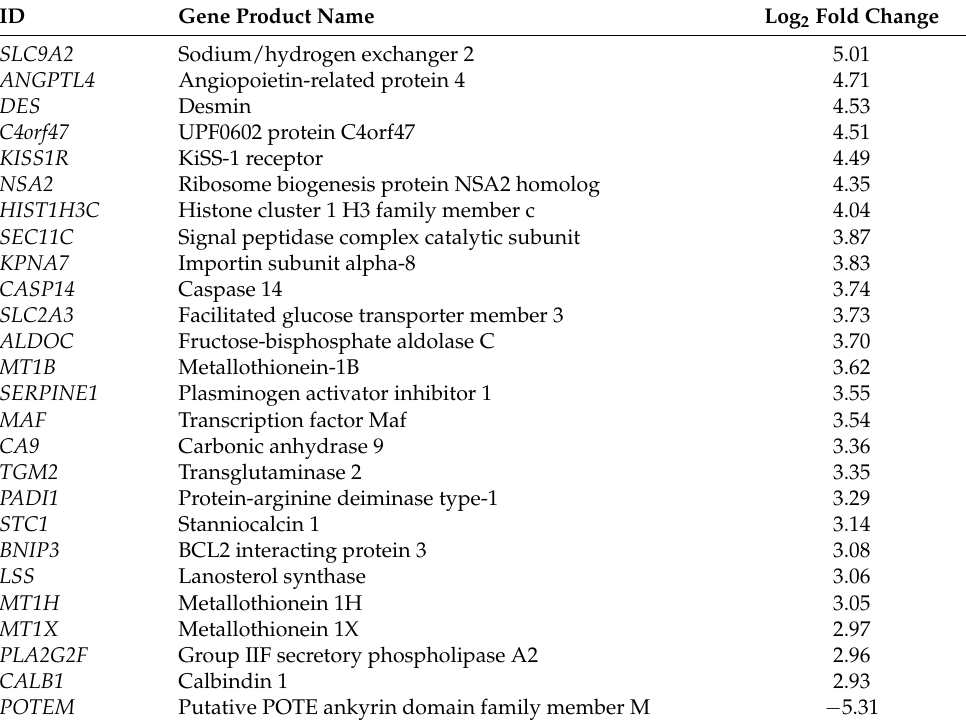
Table 1. The major up- and down-regulated genes in HaCat cells after 24 h of